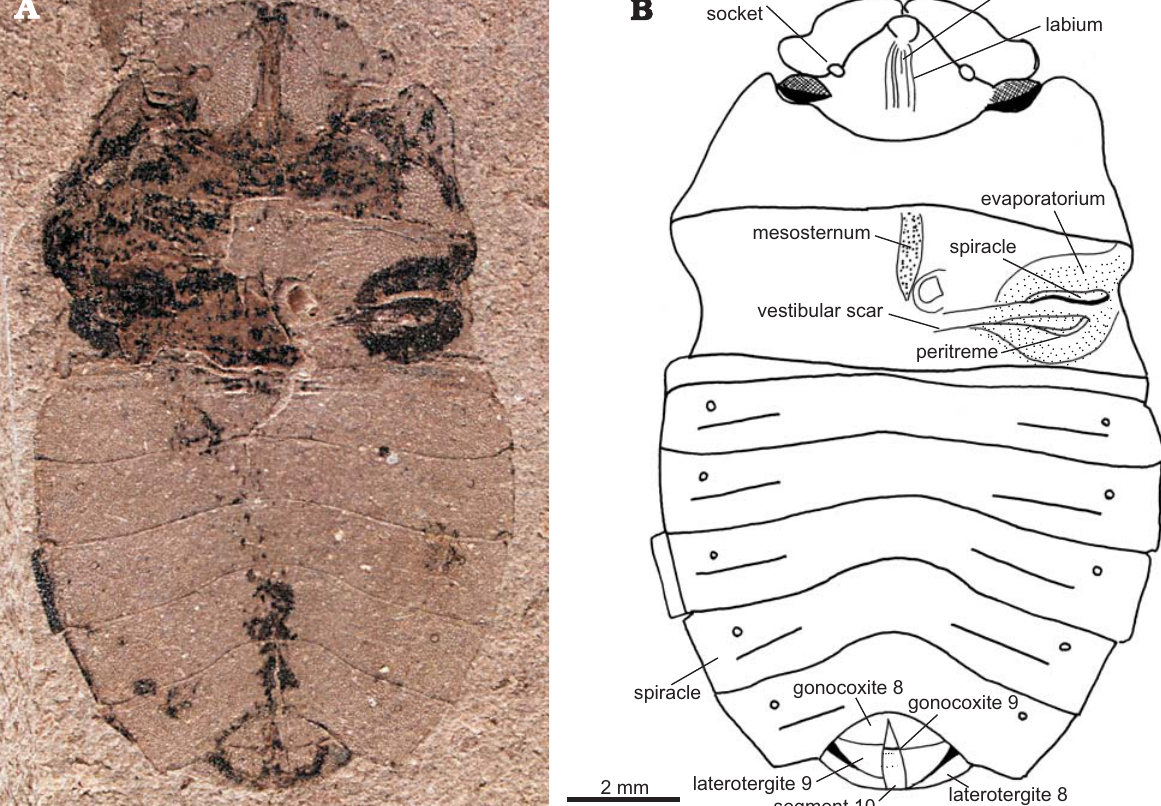
Fig. 2. Ventral habitus of female of pentatomoid bug Chinchekoala qunita gen. et sp. nov., holotype MPEF-PI 944b from Laguna del Hunco (Chubut, Argentina); Ypresian, lower Eocene. Photograph ( A ), camera lucida drawing ( B